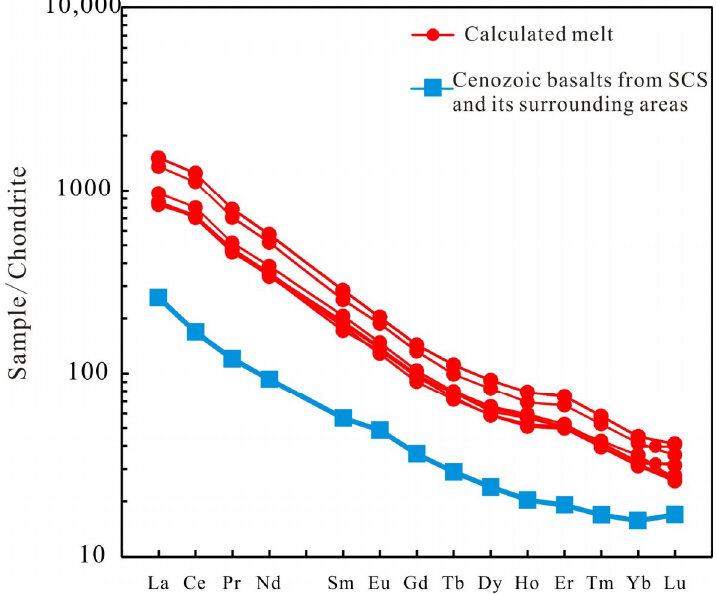
Figure 8. Calculated chondrite-normalized REE patterns of the parental magma of the clinopyroxenes. The hypothetical melt is compared to the intraplate basalt. Data for the Cenozoic basalts are from [7].